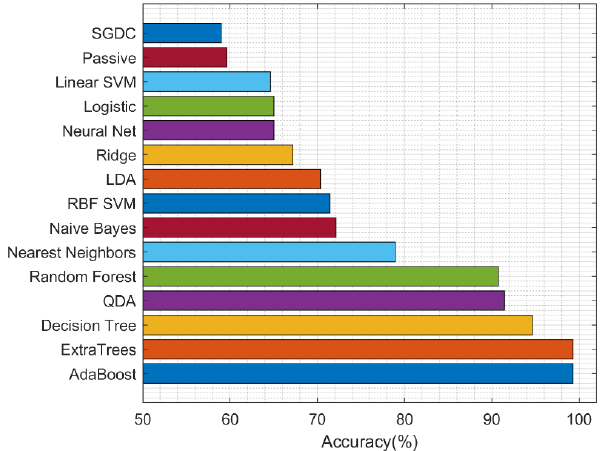
Figure 4. Performance of machine learning models.